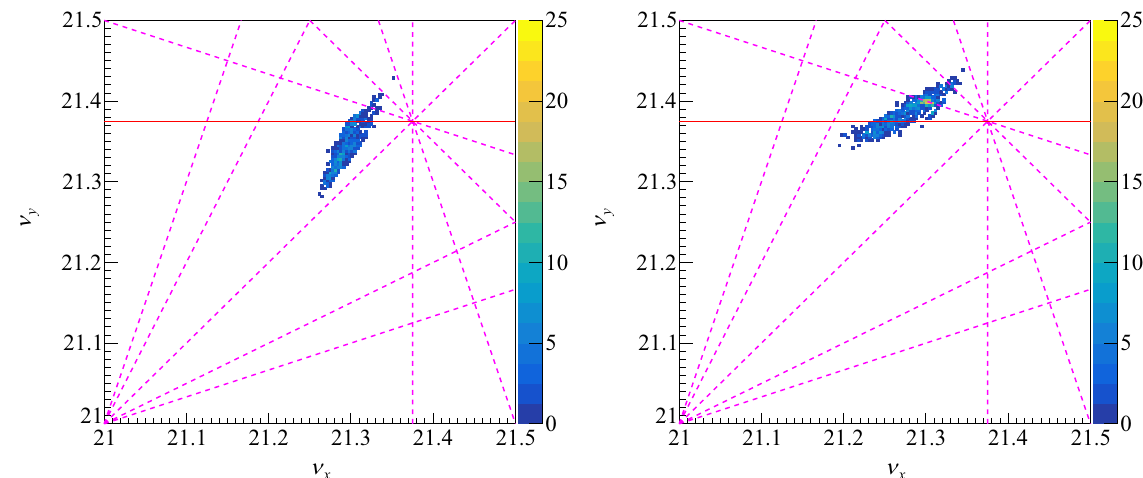
FIG. 11. Simulated tune distributions of the lost particles with J x > J y (left) and J x < J y (right) with the new optics. The tunes were calculated with one turn phase advance before the loss. The red solid lines represent the resonance 8 ν y ¼ 171 , and the magenta dashed lines represent other space charge resonances up to the eighth